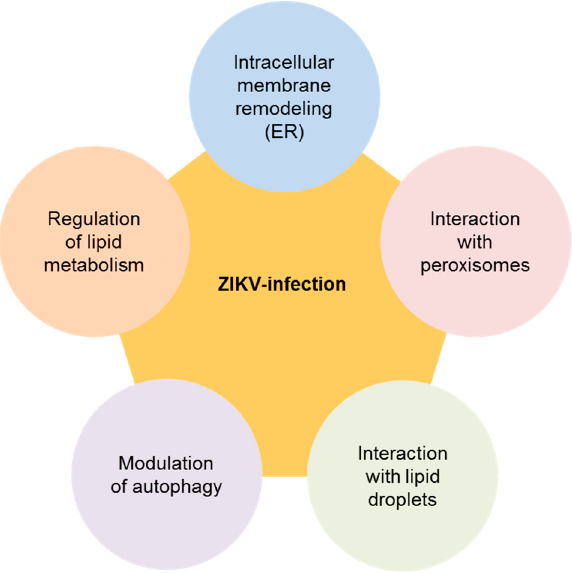
Figure 1. Multiple connections of the Zika virus (ZIKV) with lipid metabolism. The varied interactions of ZIKV with metabolic networks and lipid metabolism-related cellular structures are indicated. See the text for details.